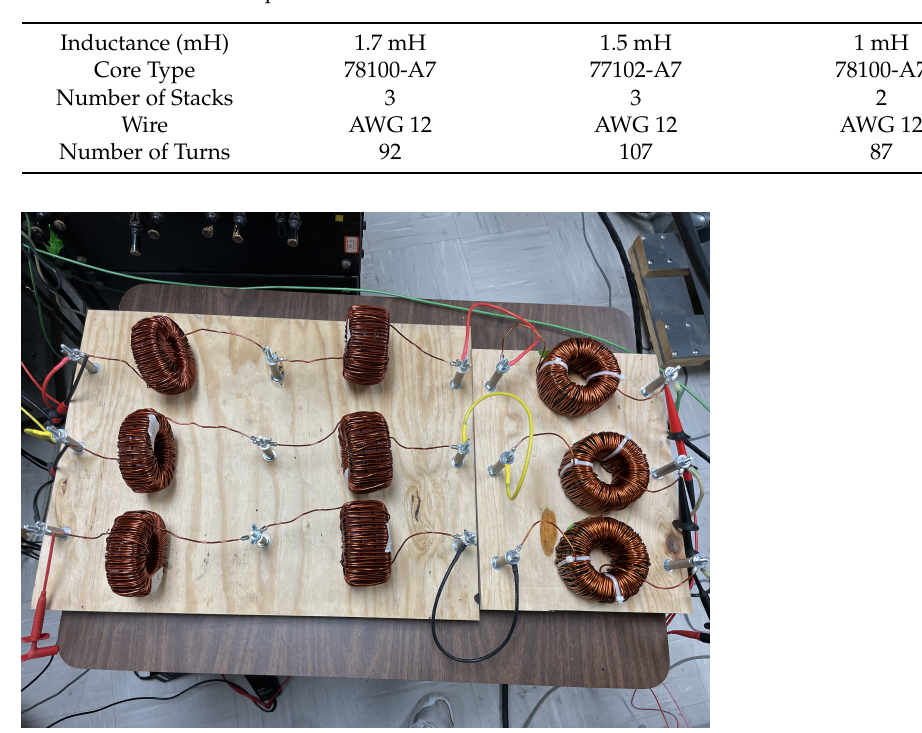
Table 2. Grid inductors’ parameters.